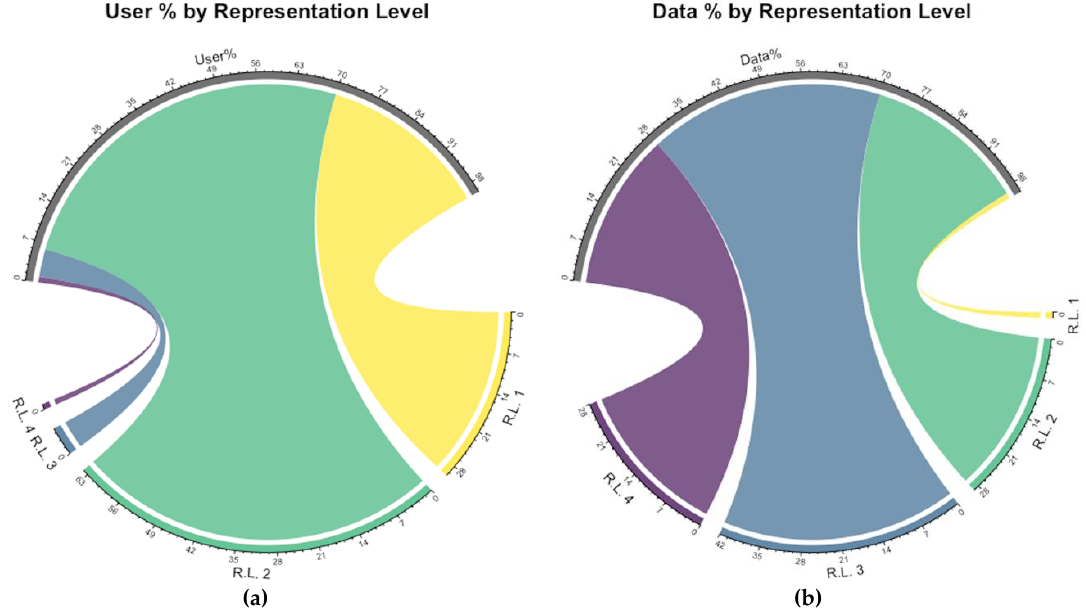
Figure 8. Representation level (R.L.) by (a) percentage of users; (b) percentage of data.